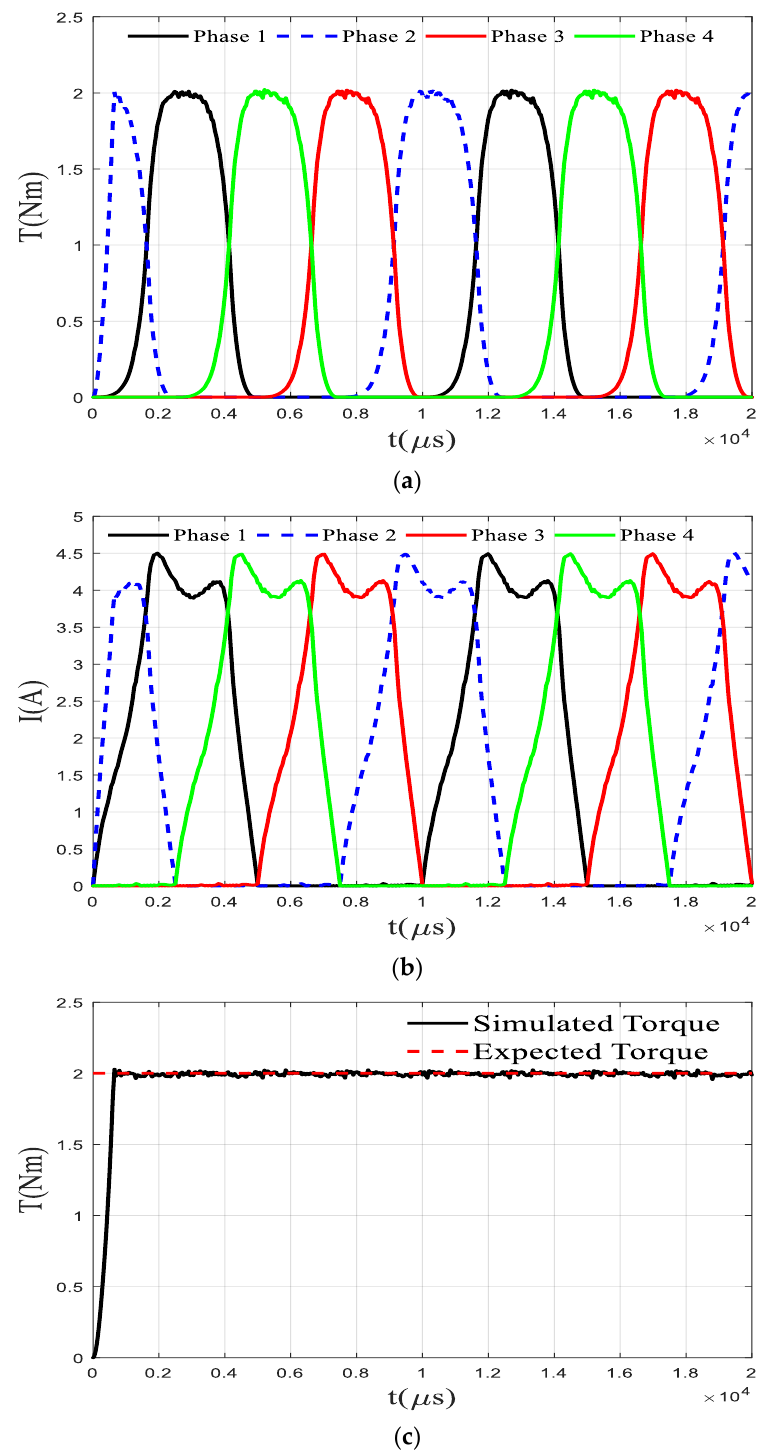
Figure 11. Results under modified TSF ( a ) Torque ( b ) Current ( c ) Sum of torque.